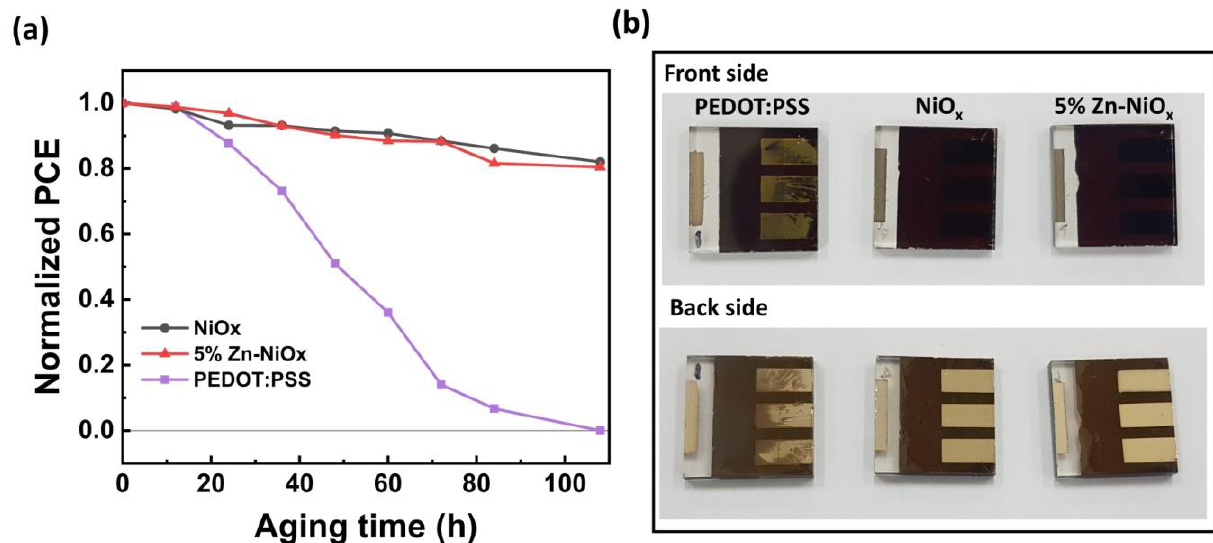
Figure 3. ( a ) Stability graph and ( b ) photograph of the PSCs made with NiO x , 5% Zn-NiO x , and PEDOT: PSS (control) HTLs without encapsulation (under ambient air at room temperature for 4 days).